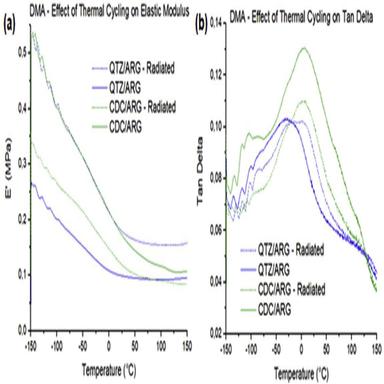
Storage Modulus (left) and Tan delta curves (right) measured by DMA in compression mode, before and after thermal cycling (TC).